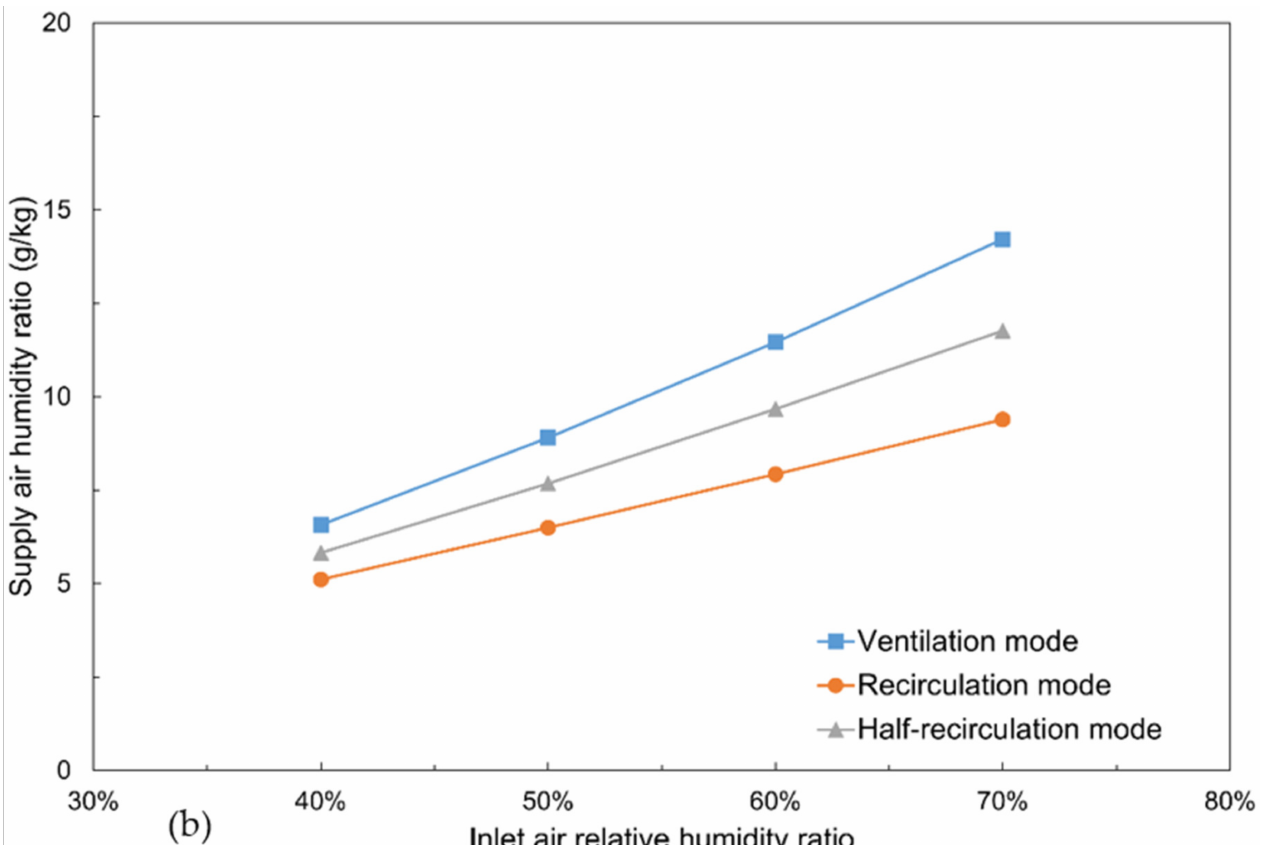
Figure 6. Effects of the ambient humidity on supply air ( a ) temperature and ( b )